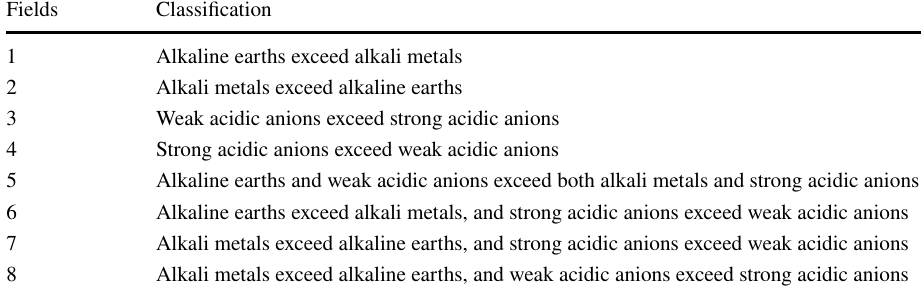
Table 3 Hydrogeochemical classification of groundwater in the study area (Chadha